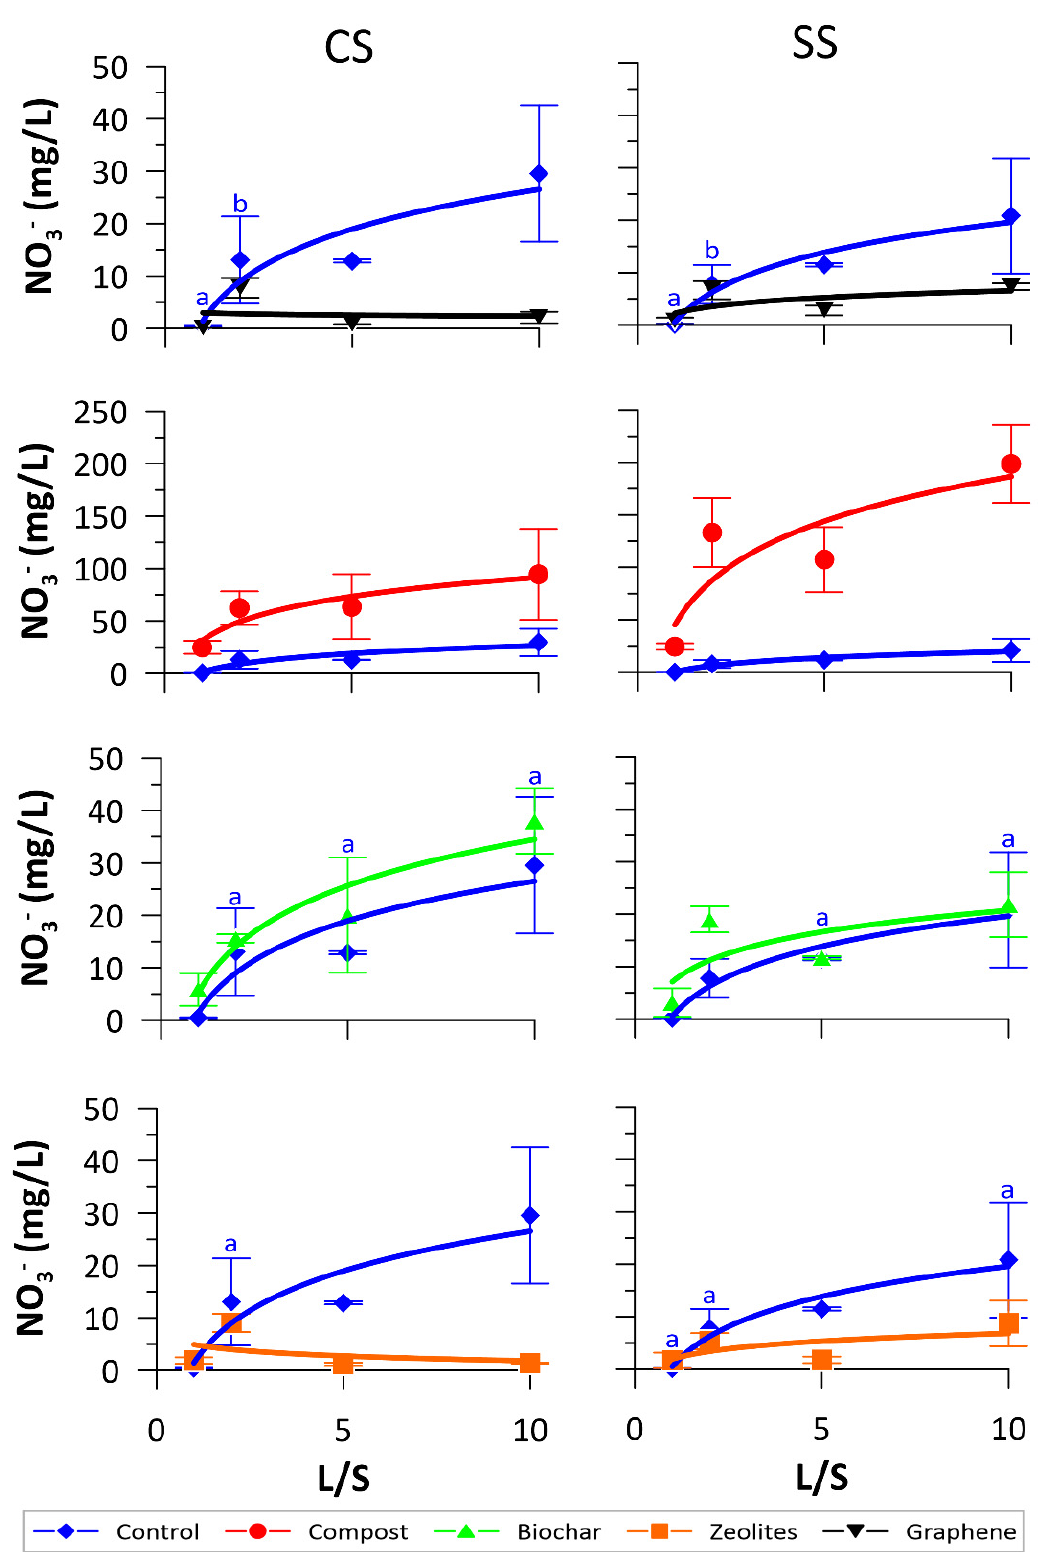
Figure 7. NO 3- concentrations in SSE batches with CS ( left panels ) and SS ( right panels ) soils versus L/S ratios values at the end of the monitoring period. Error bars denote standard deviations calculated on three replicates, while lines are best fit natural logarithmic curves. Different letters indicate statistically different means at 0.05 confidence.